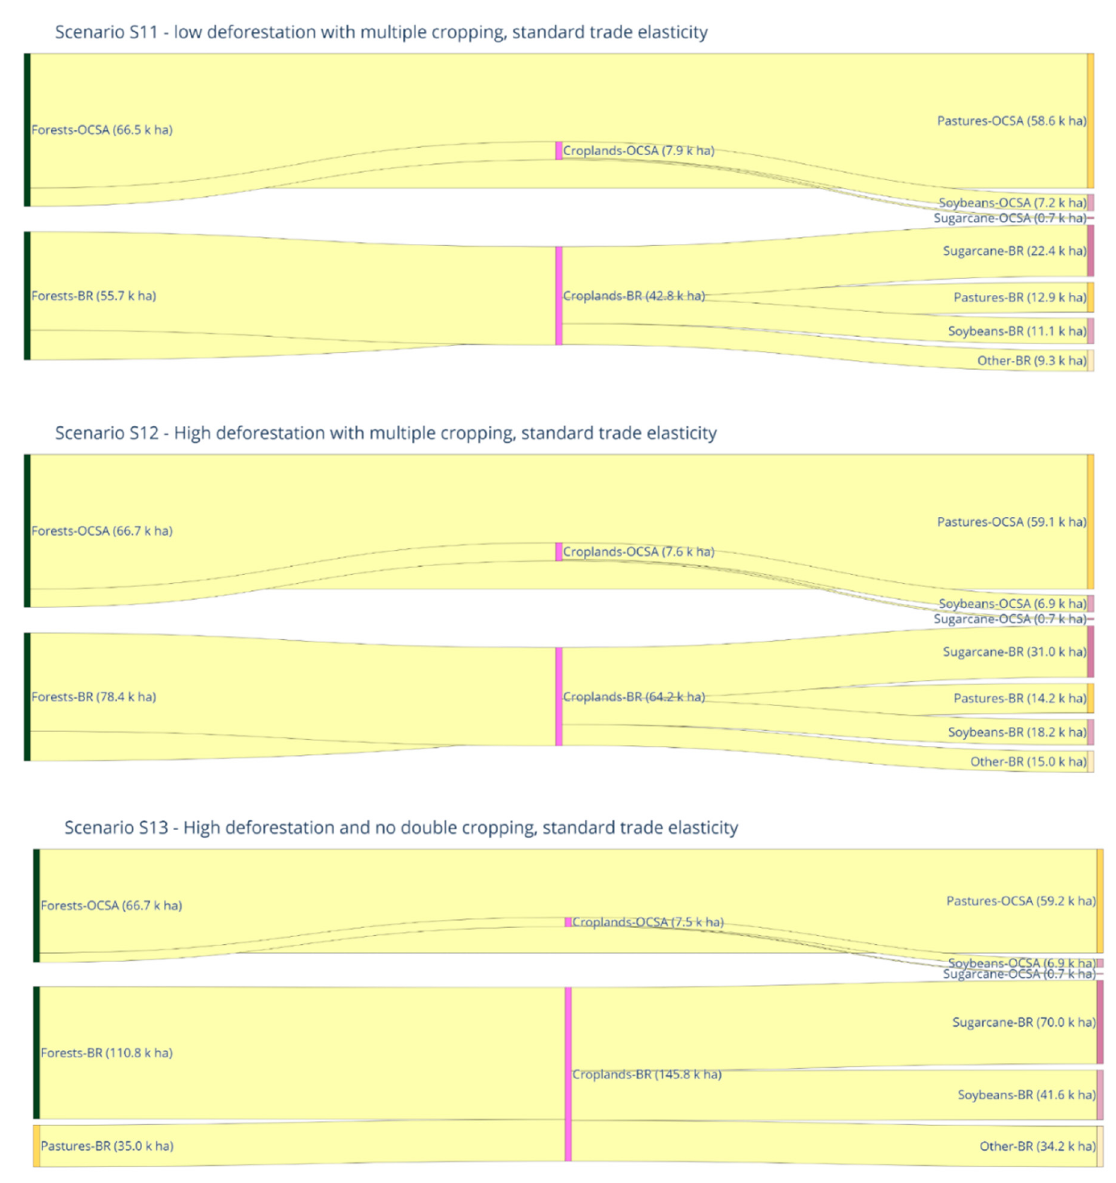
Figure 4. Land use change transitions for Brazil (BR) and other countries of South America (OCSA) under low trade elasticities scenarios (S11, S12, and S13).